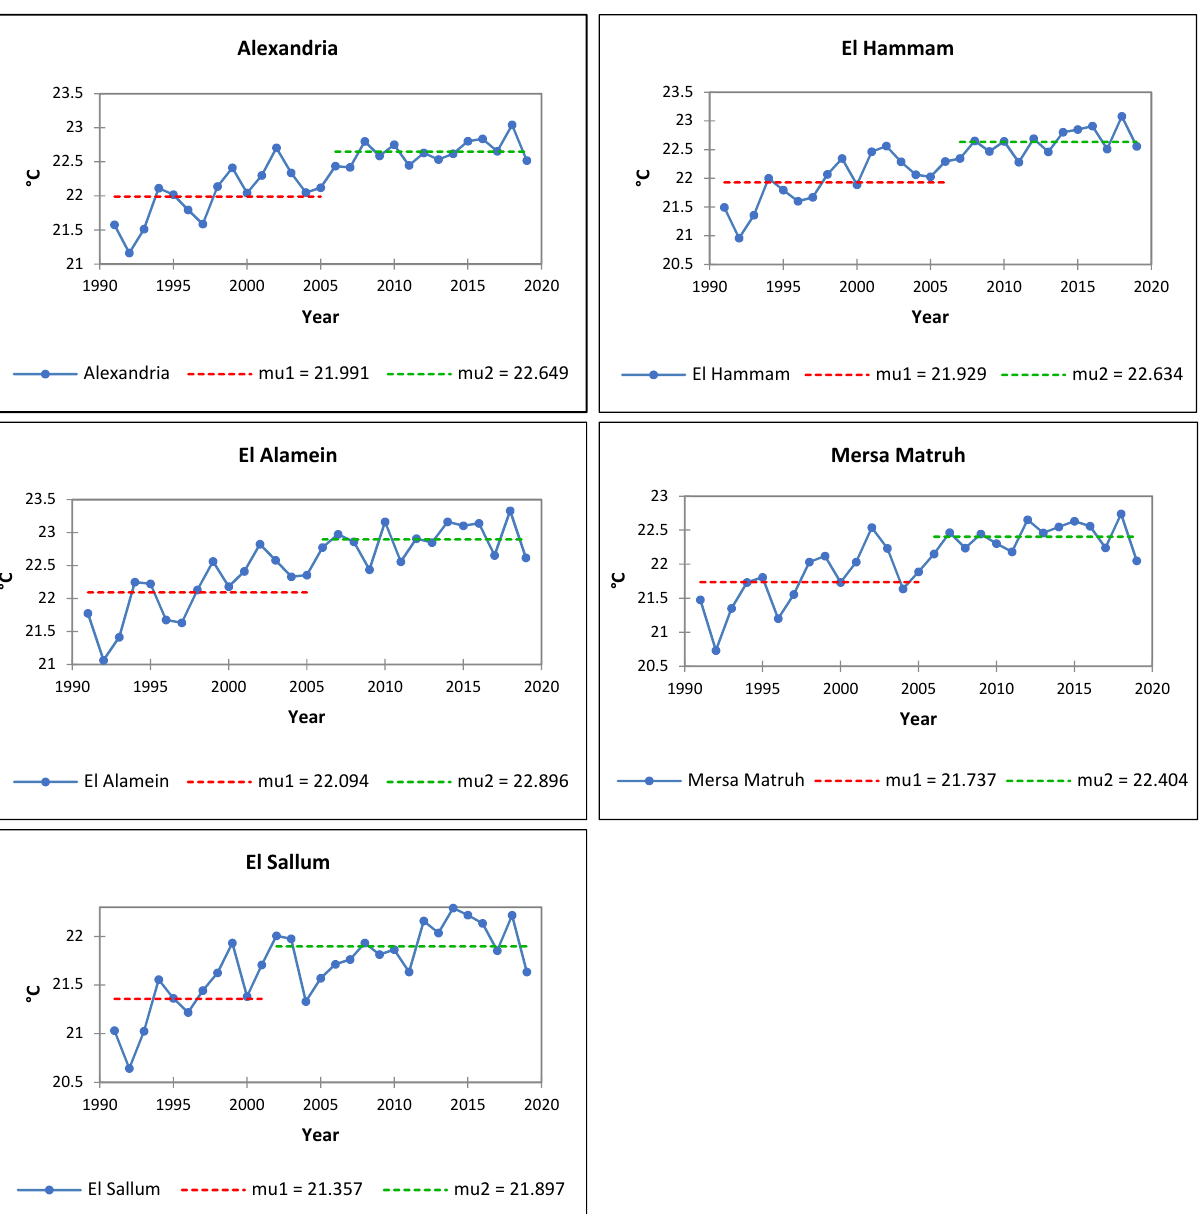
Figure 5. Pettit homogeneity test for all stations in each site of measurement of SST.